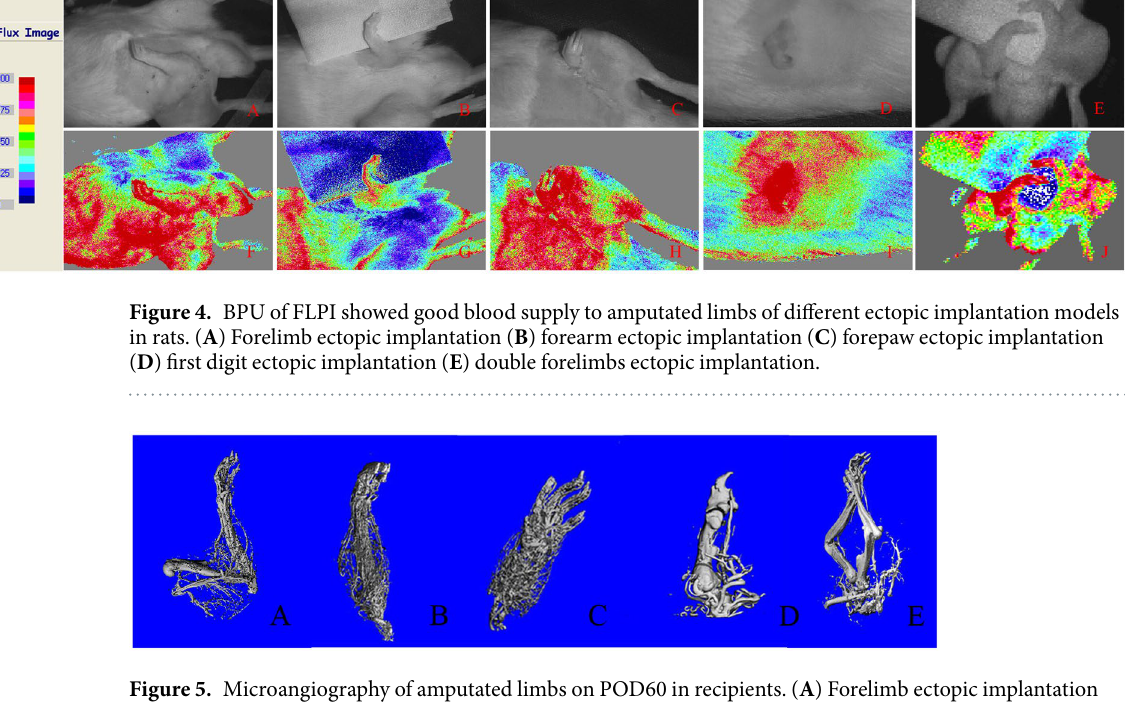
Figure 5. Microangiography of amputated limbs on POD60 in recipients. ( A ) Forelimb ectopic implantation ( B ) forearm ectopic implantation ( C ) forepaw ectopic implantation ( D ) first digit ectopic implantation ( E ) double forelimbs ectopic